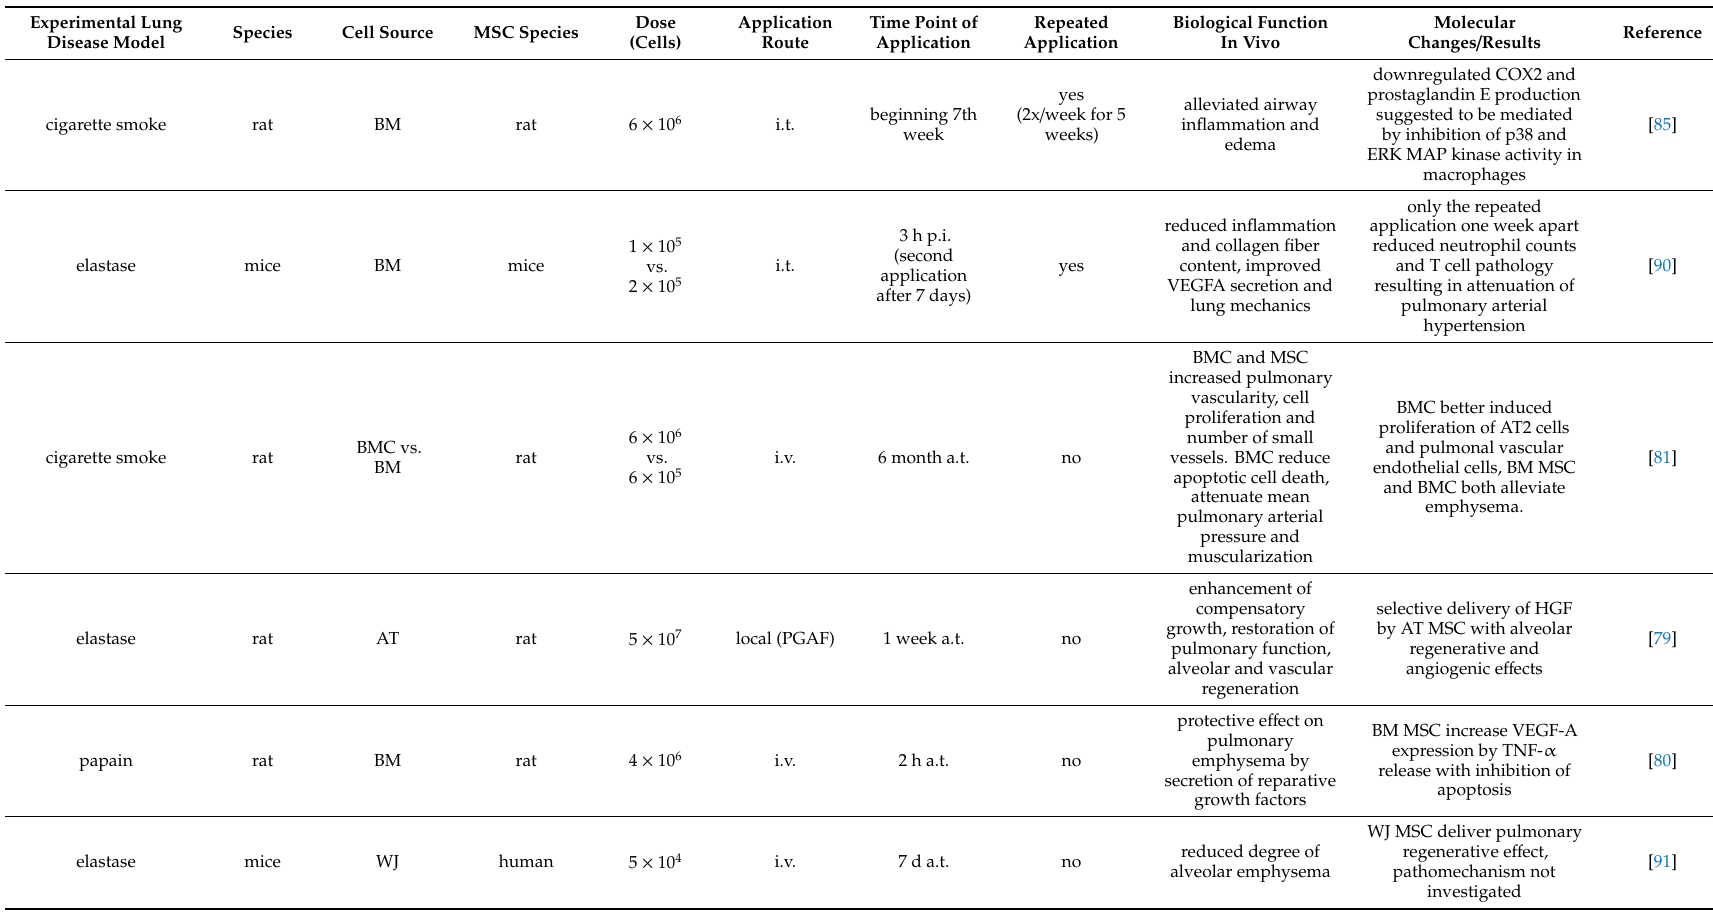
Table 4. Summary of important preclinical studies in rodents studying the therapeutic potential of MSC for